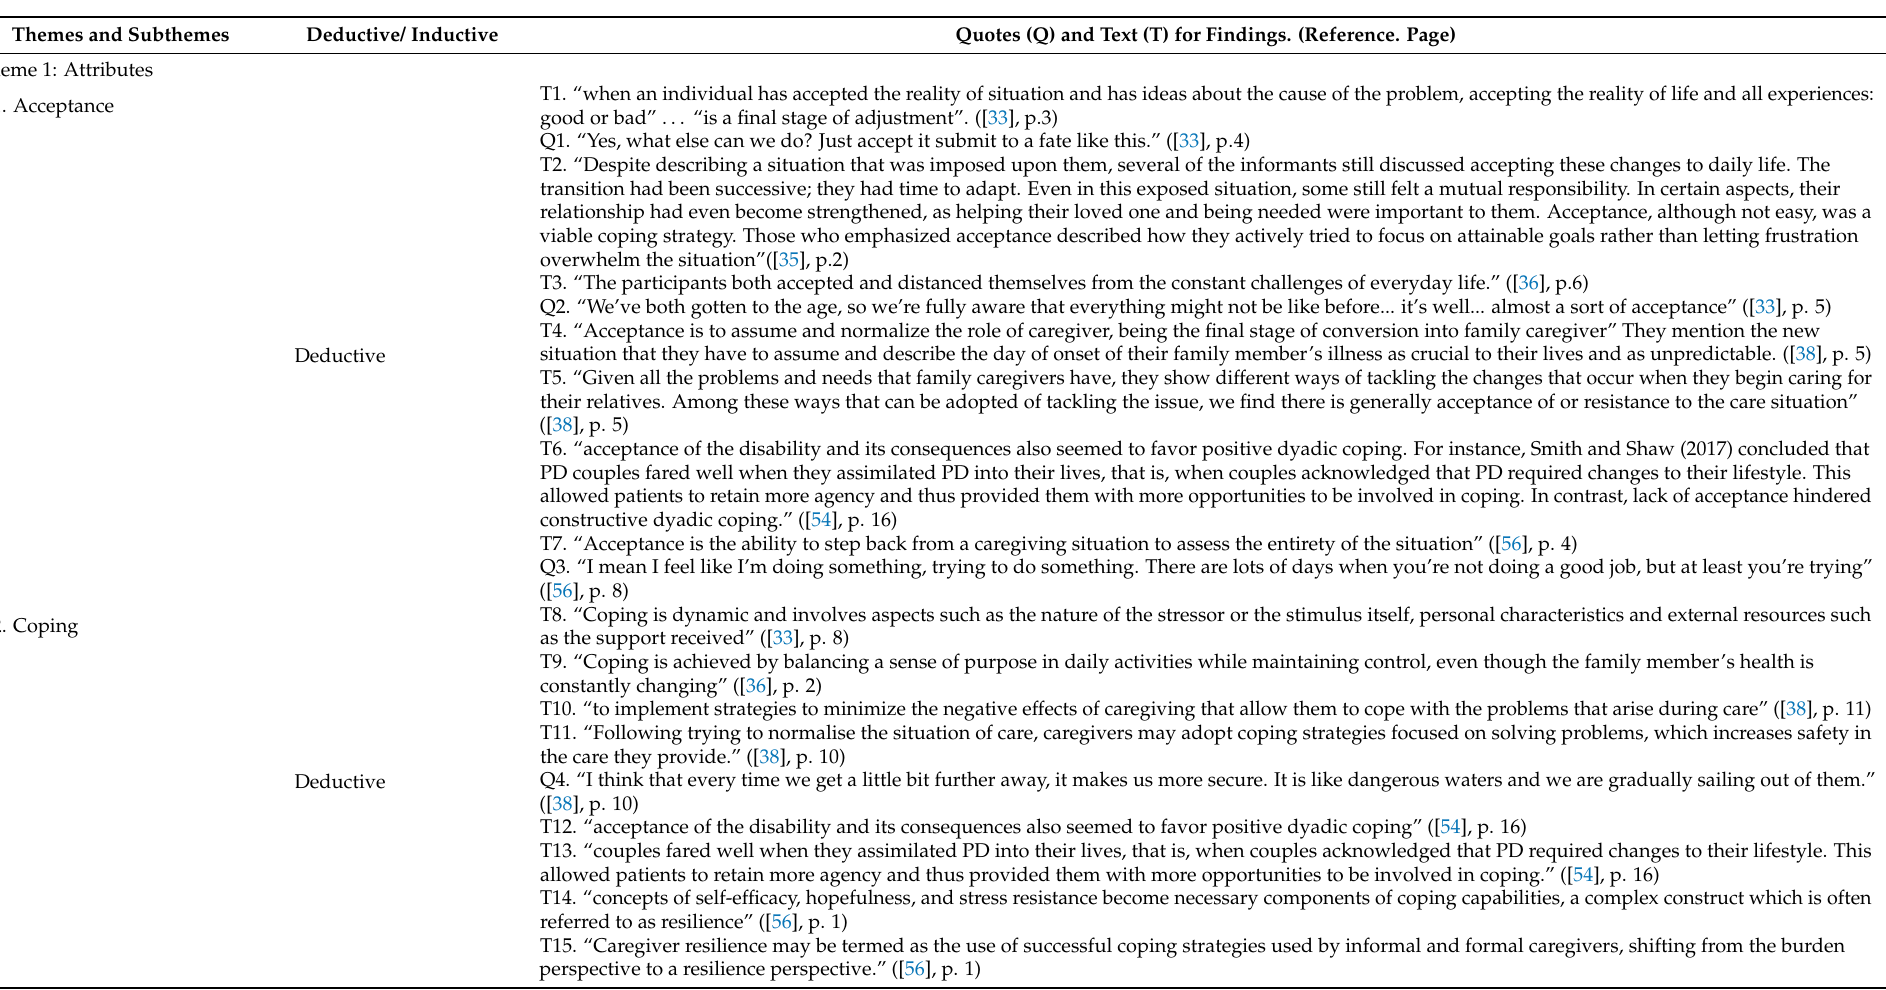
Table 5. Quotes and text from findings: reviewed